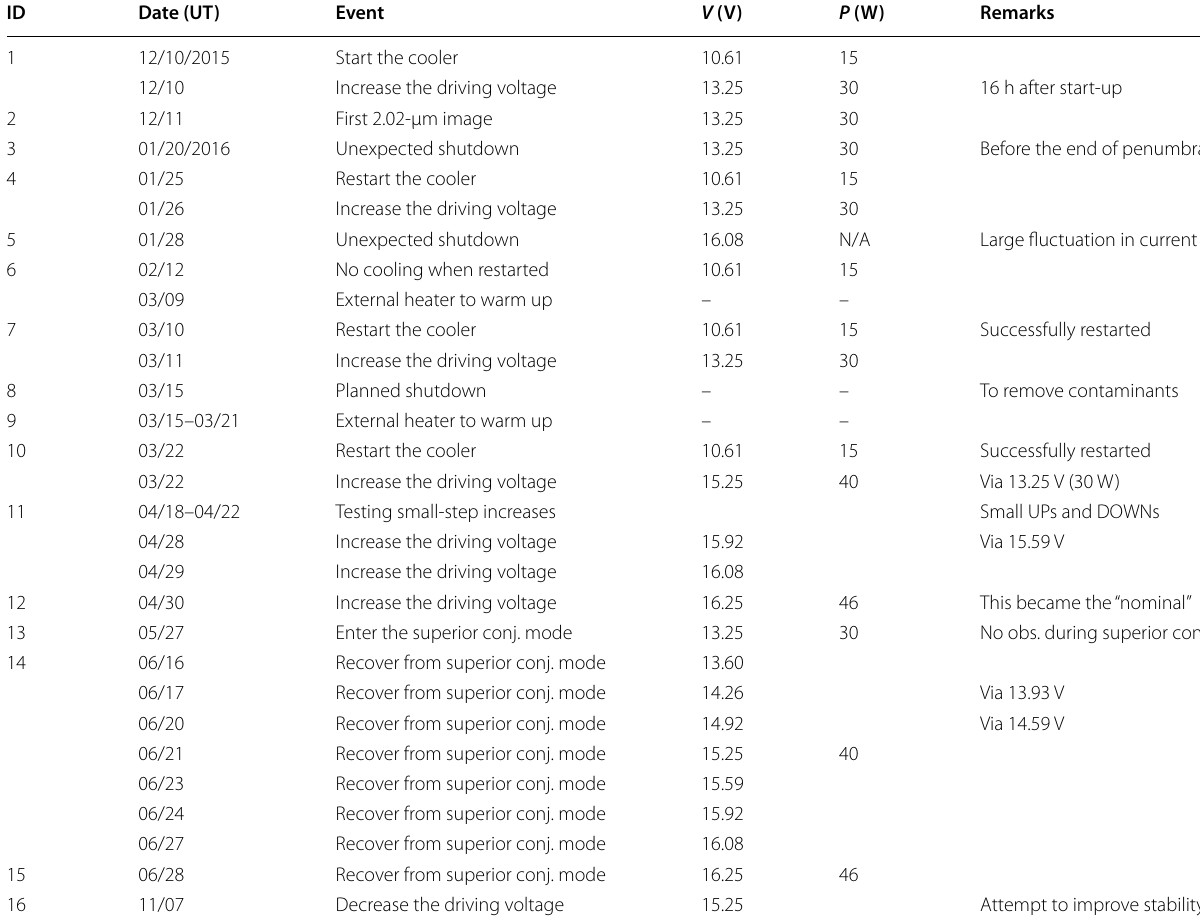
Table 1 Operation of IR2